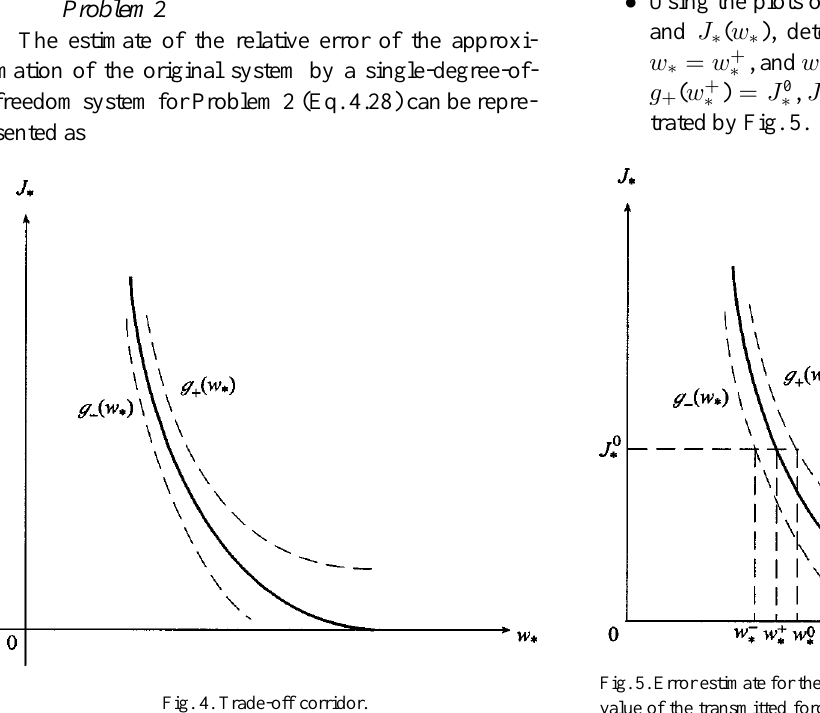
Fig. 4. Trade-off corridor.